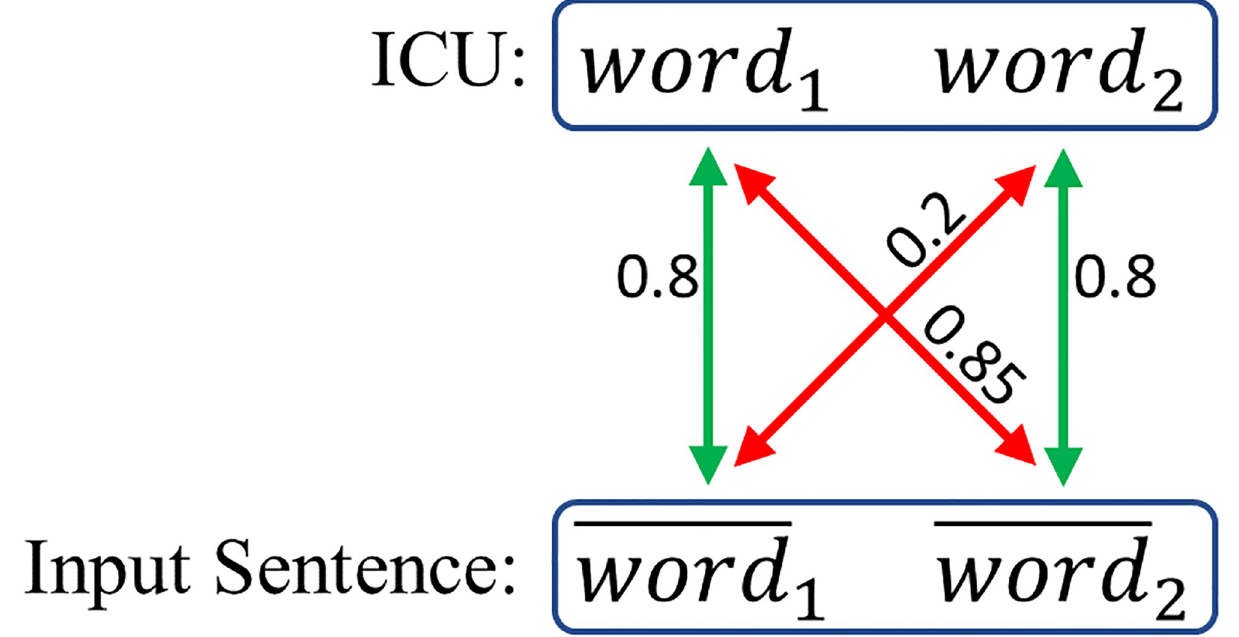
Fig 3. Picture description task: Optimal pairing is found by solving a maximum weight matching in bipartite graphs. Using a threshold of 0.75, a greedy algorithm would result in pairing word 1 with word � weight matching.